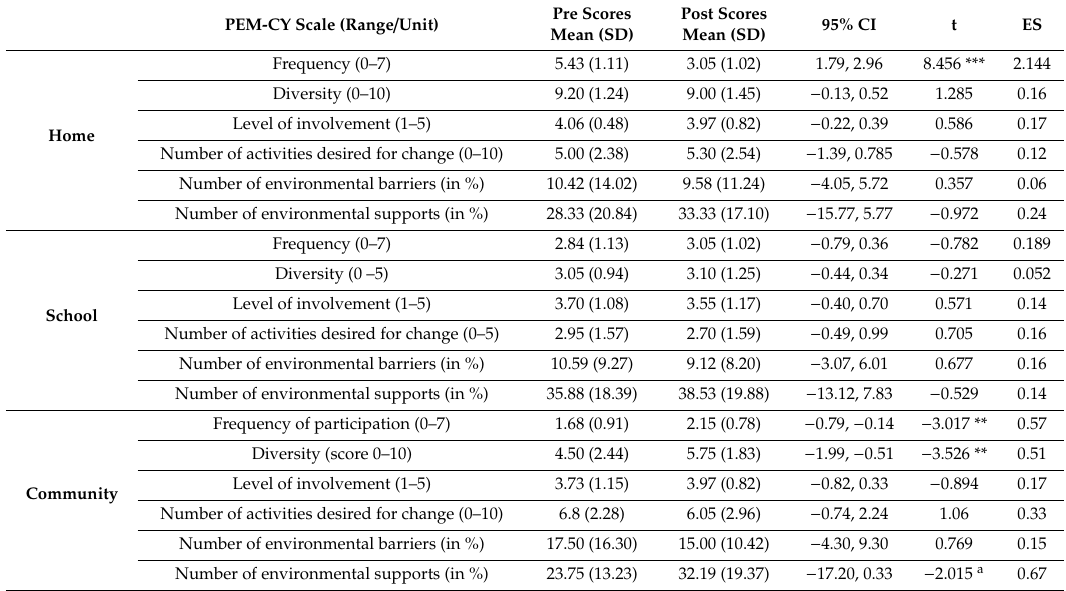
Table 2. Setting-level Participation and Environment Measure for Children and Youth mean scores in the home, school, and community (n =